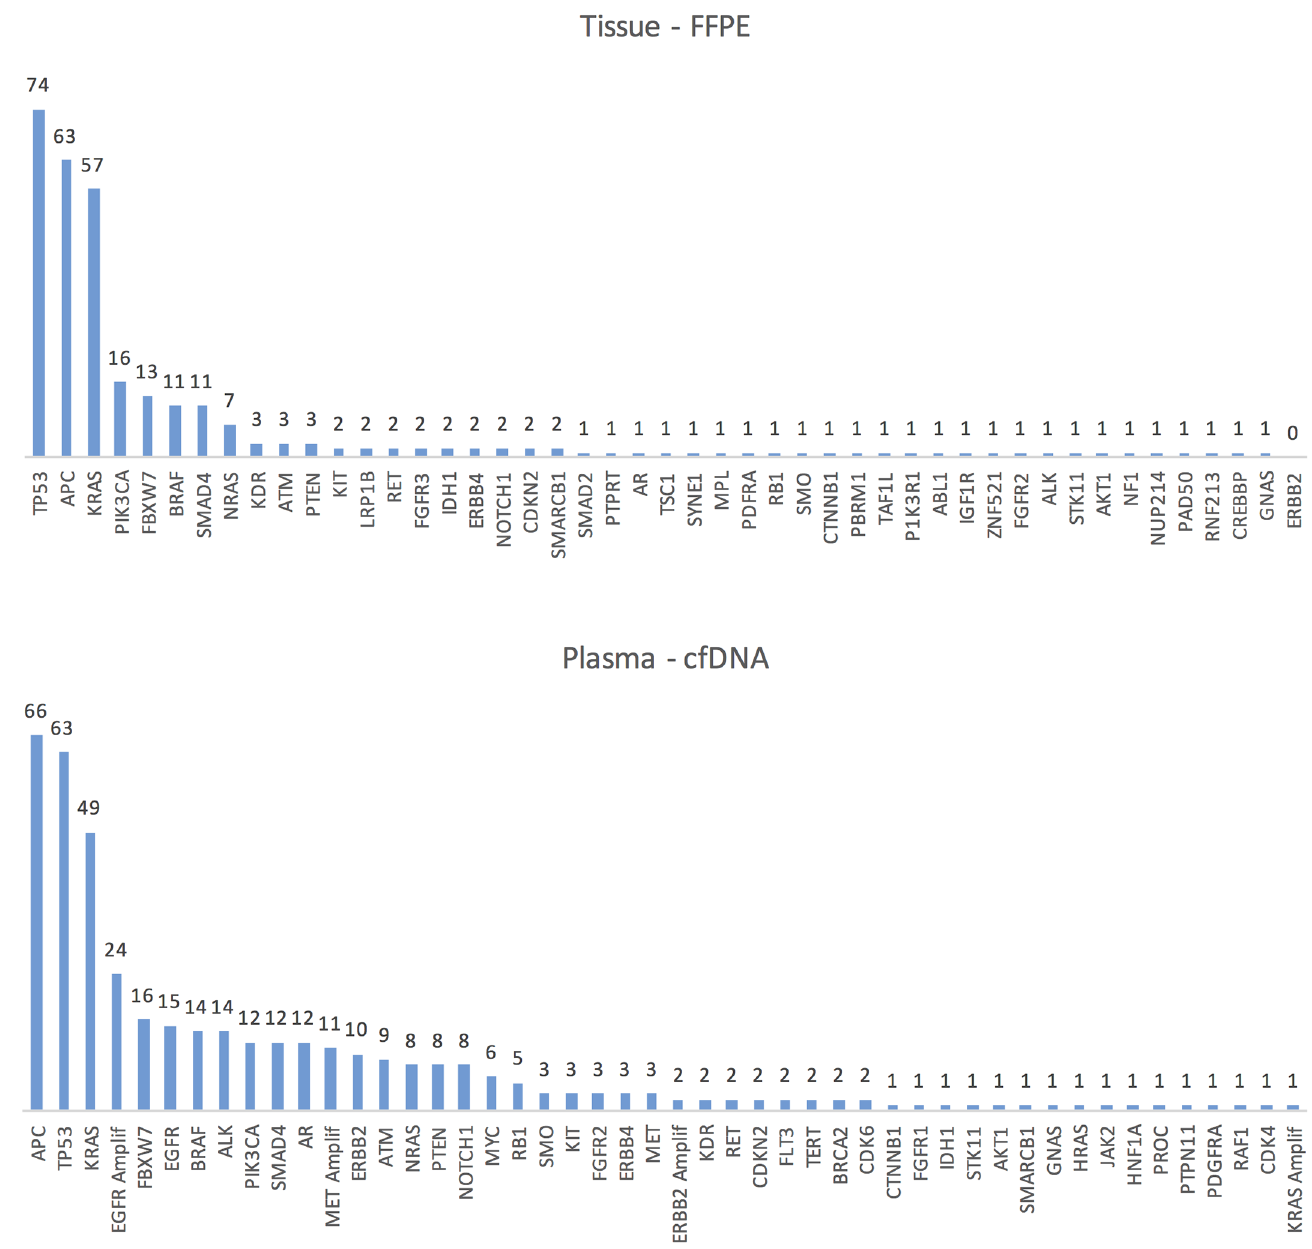
Fig 1. Number of patients with genomic alterations detected by both FFPE and cfDNA analysis. FFPE = formalin-fixed, paraffin-embedded tissue; cfDNA = cell-free DNA; Amplif = amplification.